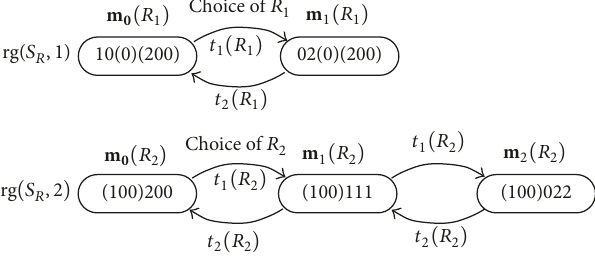
Figure 3: Graph of reachable markings of a set of alternative Petri nets.